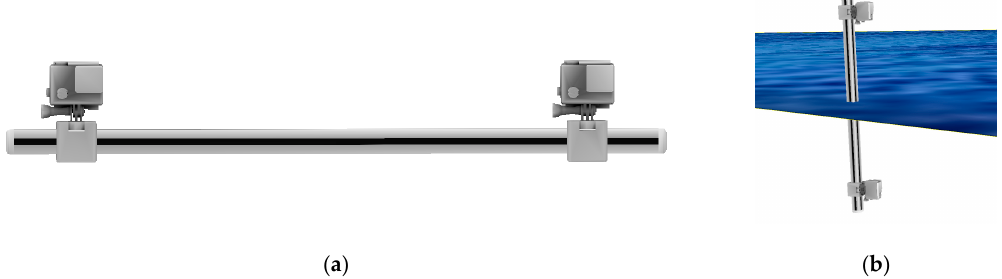
Figure 4. Example of stereo camera rig made of two GoPro cameras ( a ) used in method 2 to simultaneously survey objects below and above the water ( b ).